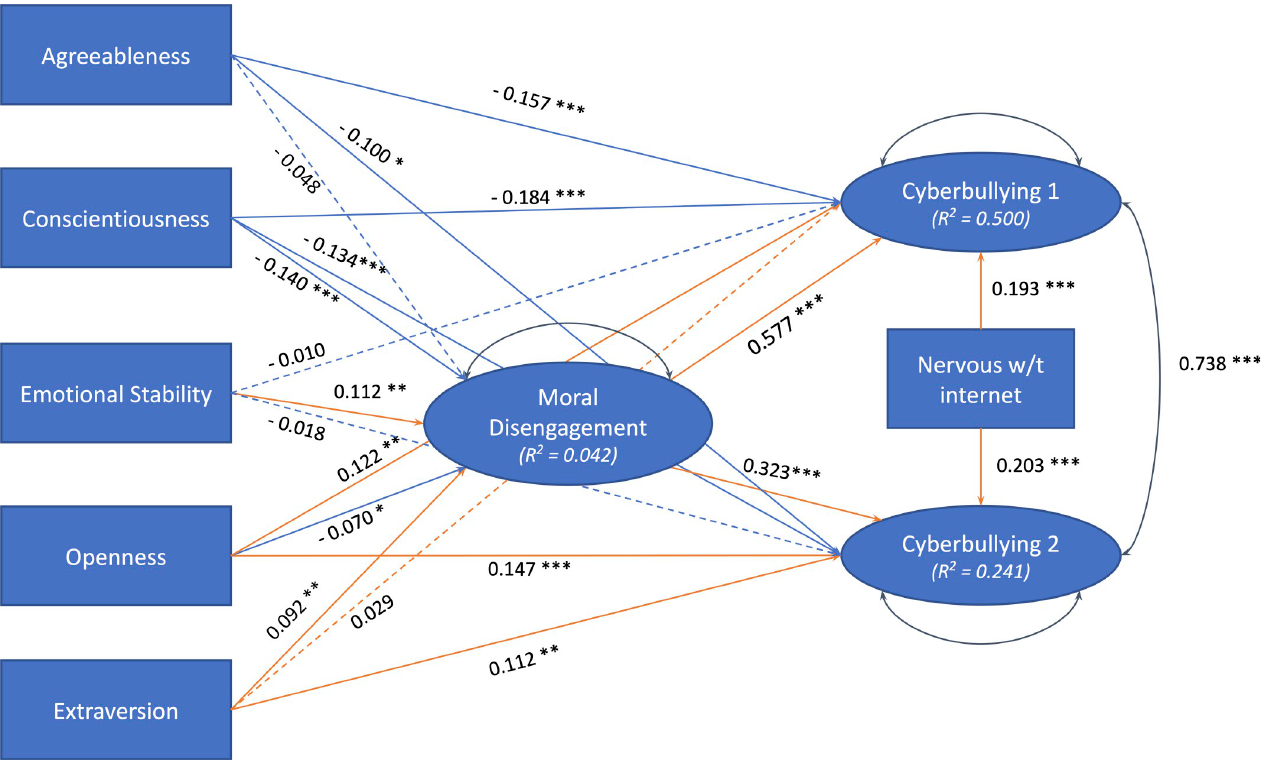
Fig 3. Structural equation model of the relationships between personality, moral disengagement, and cyberbullying factors. Ovals and rectangles represent latent and manifest variables respectively. Standardized path coefficients are reported for all the direct effects tested in the model, and the colours of the paths represent the sign of the coefficients (orange = positive; blue = negative). Insignificant effects are represented by dashed arrows. [N = 1139, χ 2 (141) = 358.64 (p = .000); RMSEA = .037 (90% CI = [.032, .042]); NNFI = .977; CFI = .964].